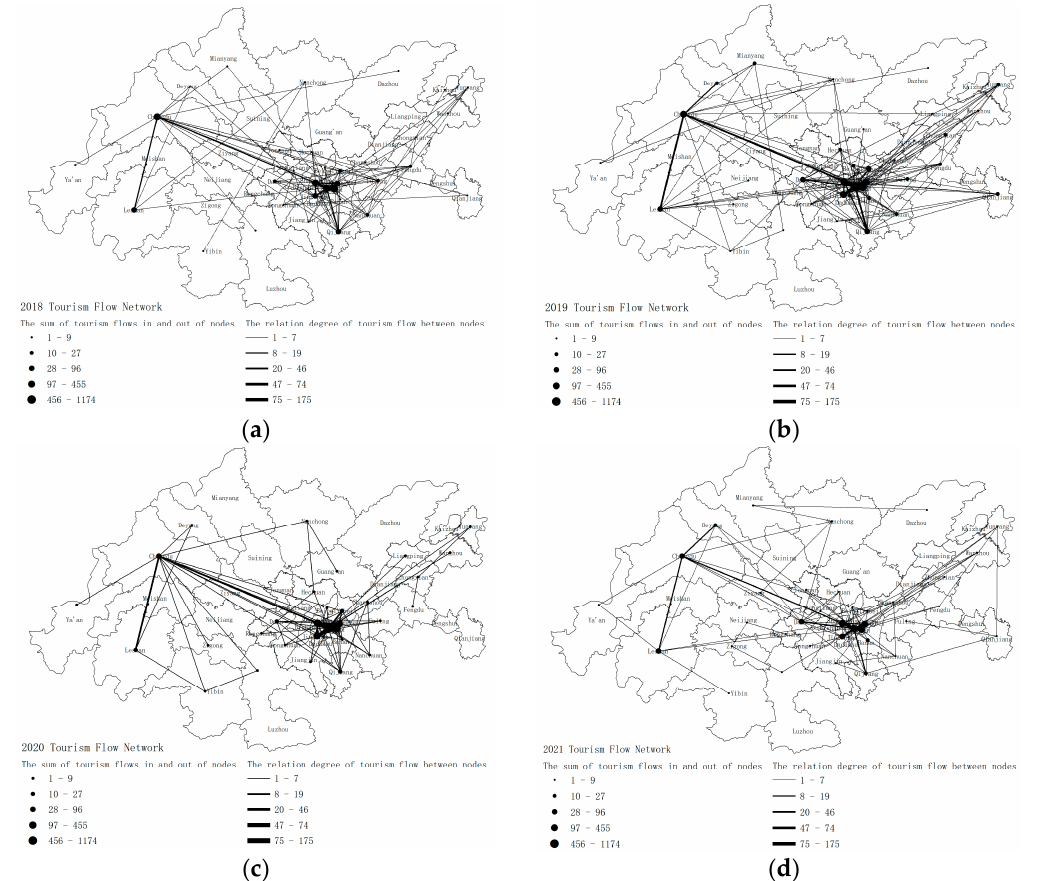
Figure 4. ( a ) Network of regional spatial tourism flows in 2018; ( b ) network of regional spatial tourism flows in 2019; ( c ) network of regional spatial tourism flows in 2020; ( d ) network of regional spatial tourism flows in 2021.